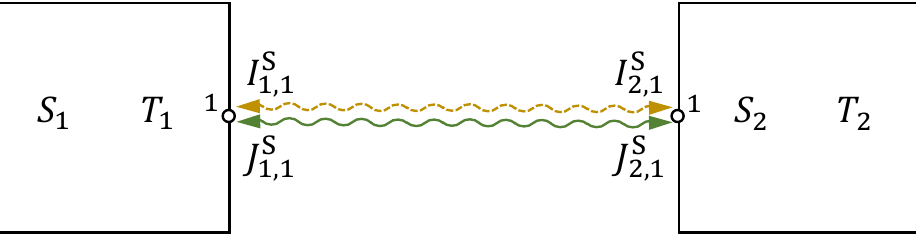
Figure 4. Heat conduction between two reservoirs.